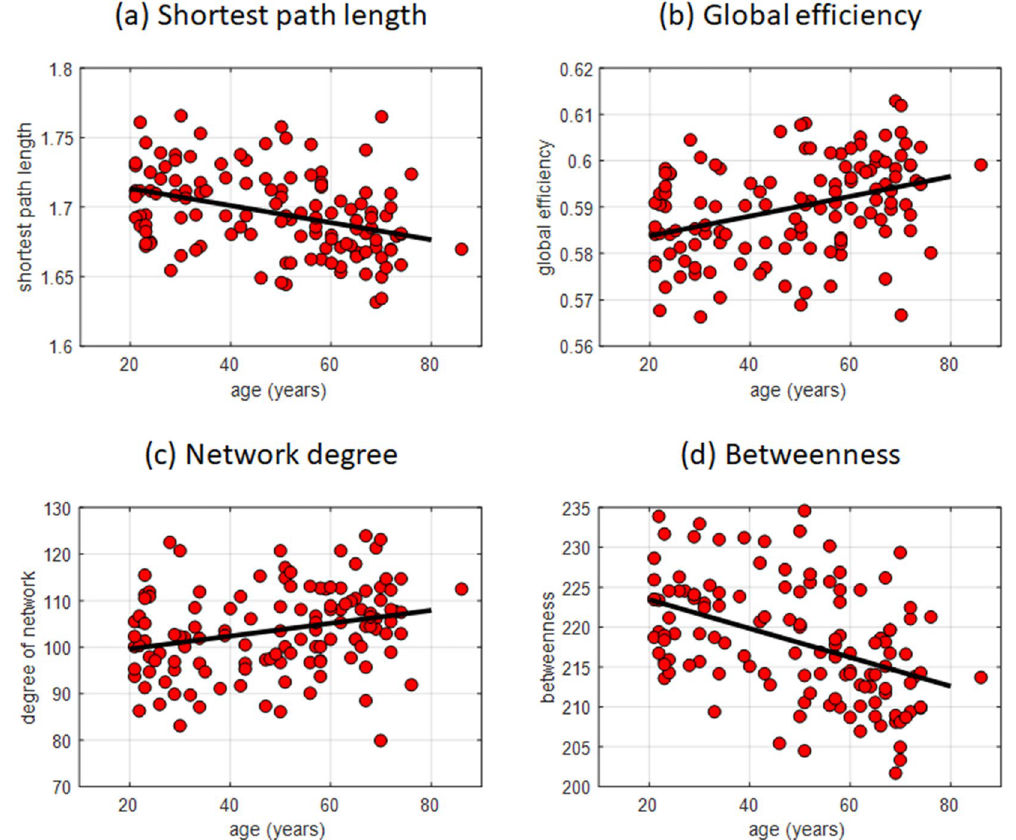
Figure 3. Scatter plots of several network measures exhibiting significant correlation with age after adjusting for sex and ACE-R total score: ( a ) shortest path length ( r = − 0.37, p = 2.53 × 10 − 5 ), ( b ) global efficiency ( r = 0.37, p = 2.24 × 10 − 5 ), ( c ) degree of network ( r = 0.29, p = 0.0011), and ( d ) betweenness ( r = − 0.42, p = 1.03 × 10 − 6 ). Network measures were estimated using a network-defining correlation threshold set to 0.2.